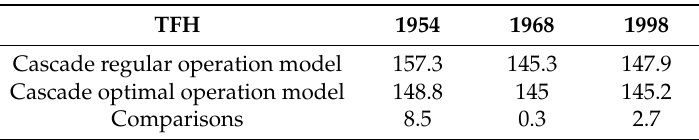
Table 10. The highest water level of TGR by two models